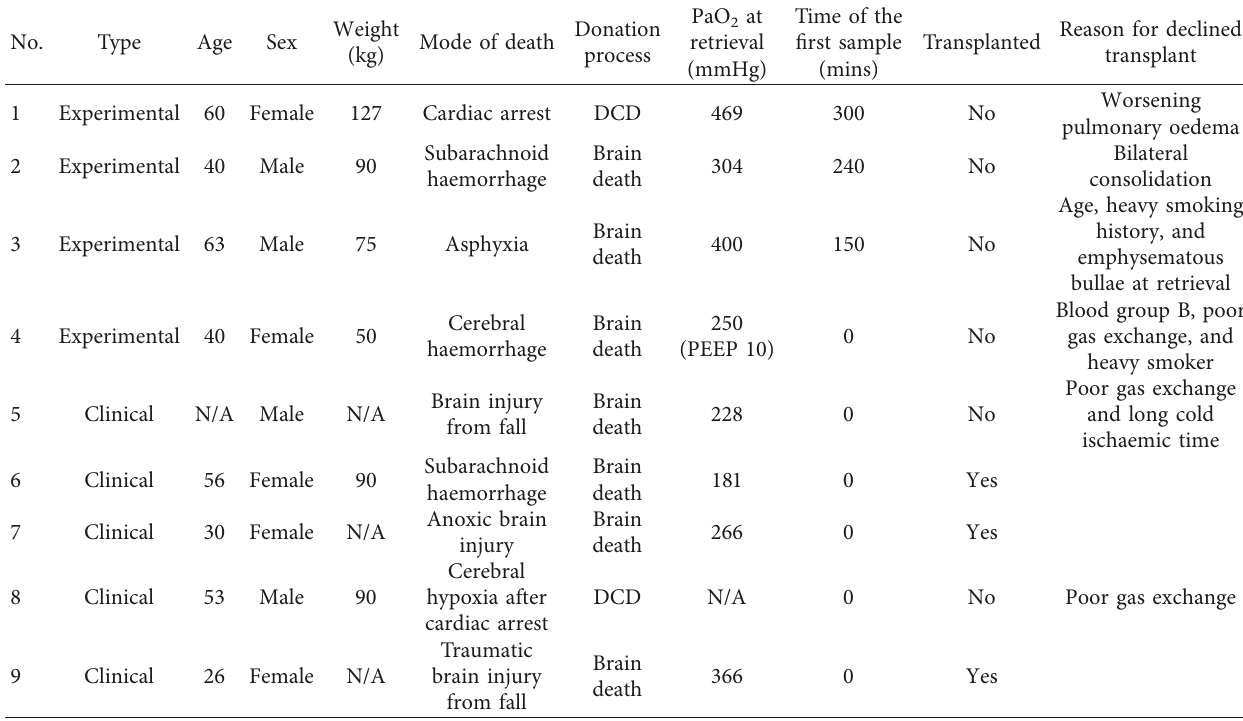
Table 1: Human donor EVLP